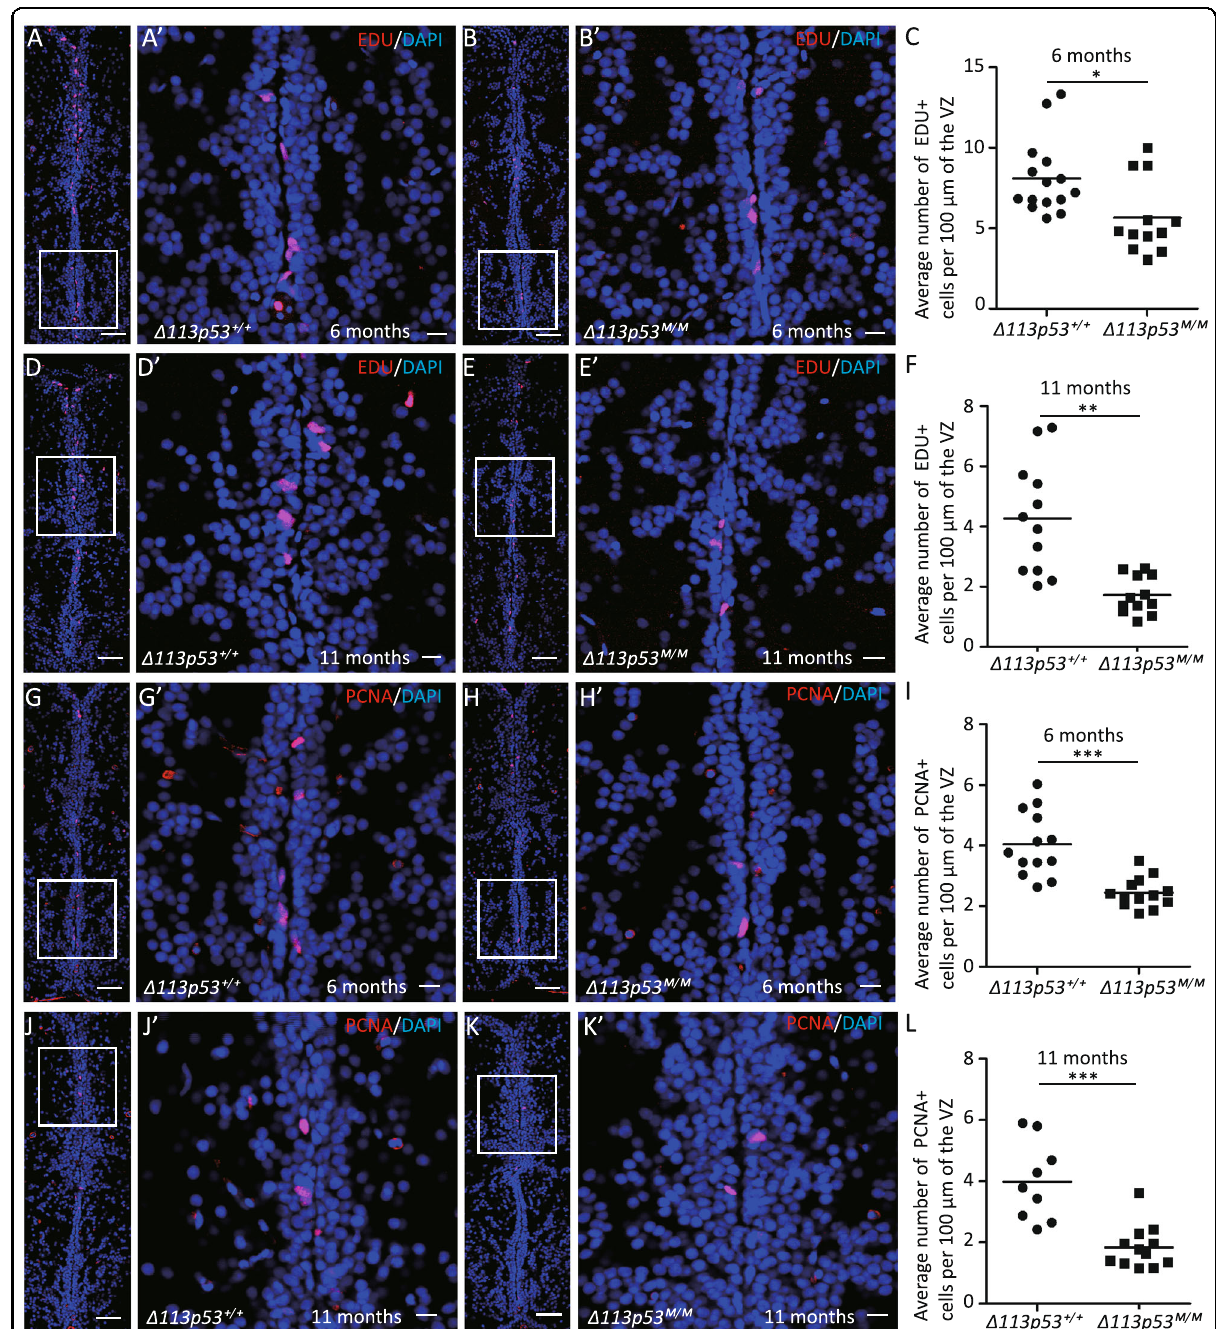
Fig. 4 Δ 113p53 promotes cell proliferation in the ventricular zone of the telencephalon. A – F The Δ 113p53 + / + ( A , D ) and Δ 113p53 M/M ( B , E ) zebra fi sh telencephalons were labeled with EDU in red at 6- and 11-months old, as indicated. G – L Cryosections of Δ 113p53 + / + ( G , J ) and Δ 113p53 M/M ( H , K ) zebra fi sh telencephalons were immunostained by anti-PCNA (in red) at 6- and 11-months old, as indicated. The nuclei were stained with DAPI (in blue). An average number of EDU + cells or PCNA + cells per 100 μ m of the ventricular zone (VZ) in one section from the middle region of each telencephalon was presented in C (6-months old) and F (11-months old) or I (6-months old) and L (11-months old), respectively. Framed areas in A , B , D , E , G , H , J , K were magni fi ed in A ’ , B ’ , D ’ , E ’ , G ’ , H ’ , J ’ , K ’ , respectively. Scale bar in A , B , D , E , G , H , J , K , 50 μ m; scale bar in A ’ , B ’ , D ’ , E ’ , G ’ , H ’ , J ’ , K ’ , 10 μ m. Each dot represents the average number of EDU + cells or PCNA + cells per 100 μ m of VZ in one section. About three to fi ve sections were chosen from the middle region of each telencephalon and at least three telencephalons were sampled in each group. Statistical analysis was performed on relevant data using the Student ’ s two-tailed t test. * P < 0.05, ** P < 0.01, *** P <